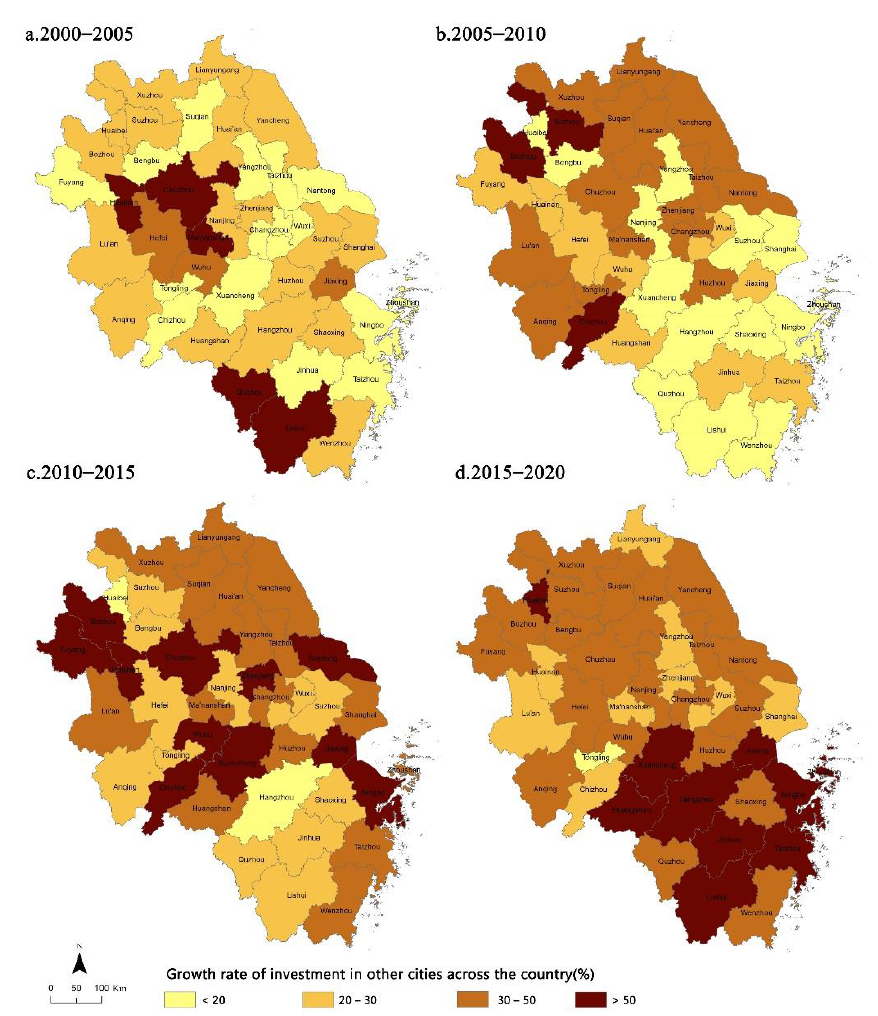
Figure 6. The investment growth rate from other cities across the country during 2000 – 2020.